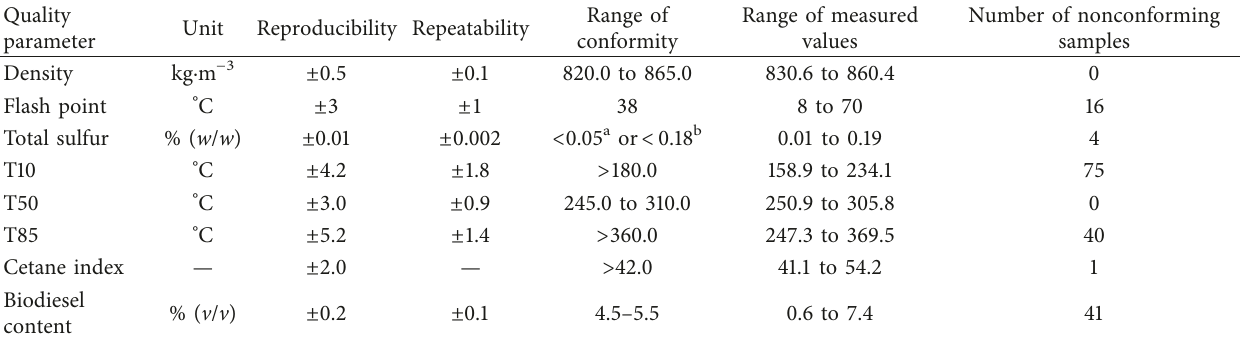
Table 2: Results of quality parameter assays using the reference methods in accordance with ANP Resolution no. 65 [41].